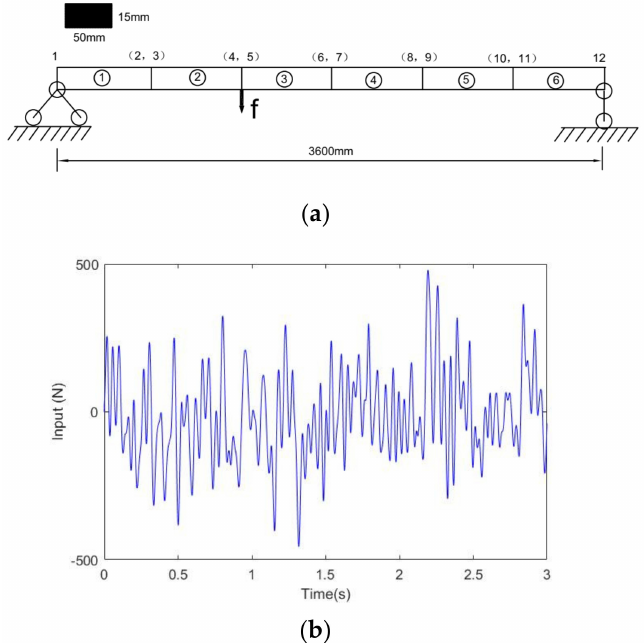
Figure 1. A simply supported beam subjected to white noise excitation. ( a ) A simply supported beam with unknown parameters; ( b ) broadband white noise